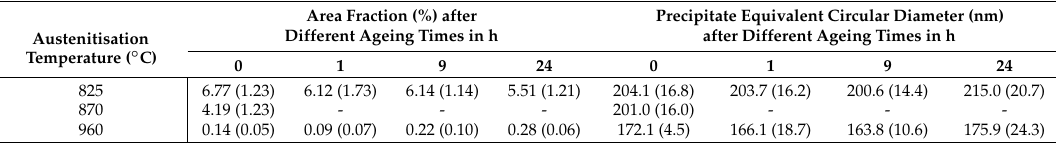
Table 2. Precipitate area fraction and precipitate equivalent circular diameter from back-scattered SEM images and image-J analysis, data are also shown in Figure 4. The numbers in brackets are the standard deviation in the values found from the images for a particular heat-treatment condition.